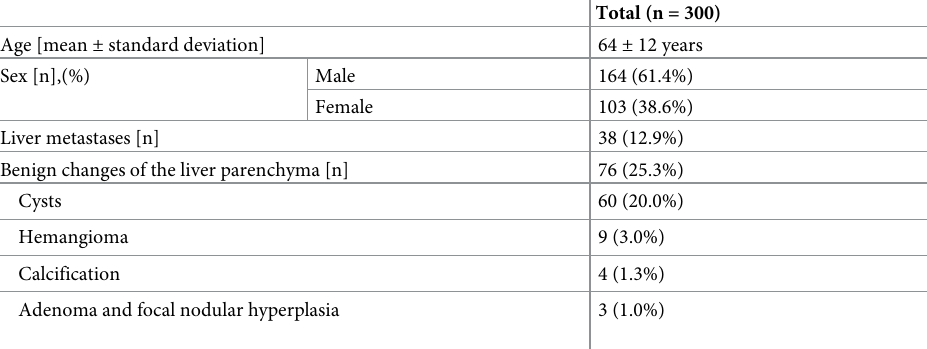
Table 1. Patient